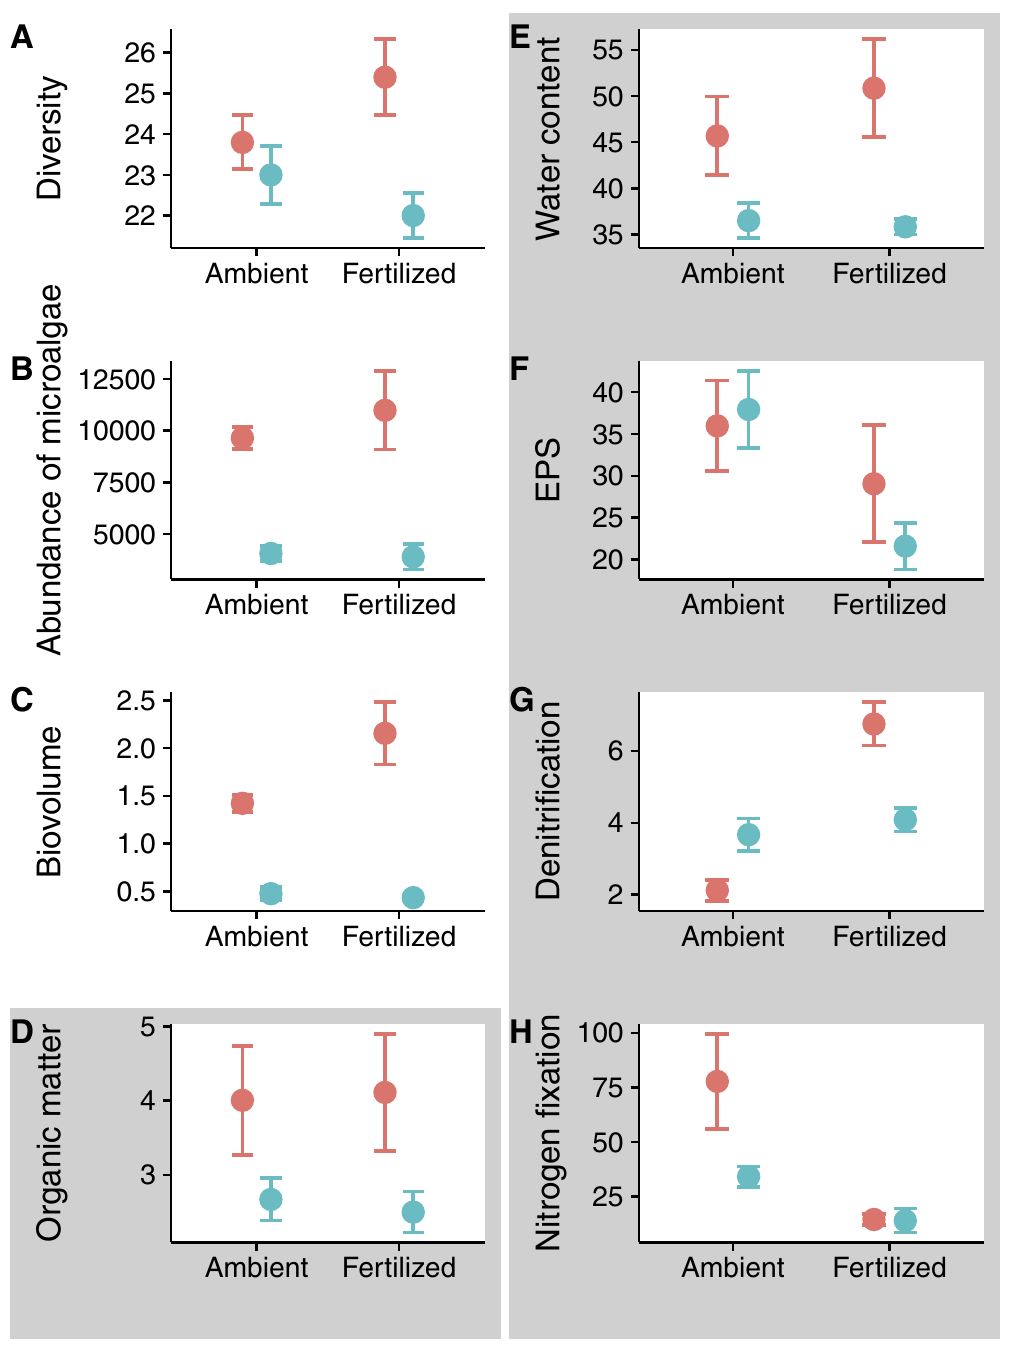
Figure 1. Effect of increased nutrients and altered consumer populations on the ( A ) diversity, ( B ) abundance (individuals mm − 2 ) and ( C ) biovolume (mm 3 cm − 2 ; an estimate of biomass) of benthic microalgae, and ecosystem functions ( D ): organic matter (%), ( E ): water content (%), ( F ): EPS ( μ g glucose cm − 2 ), ( G ): denitrification ( μ mol N 2 m − 2 h − 1 ), and ( H ): Nitrogen fixation ( μ mol N 2 m − 2 h − 1 ). Mean ± SE are represented. Statistical results are given on Supplementary Table 1. Here and in the next figures, the grayed background is used to highlight results of ecosystem